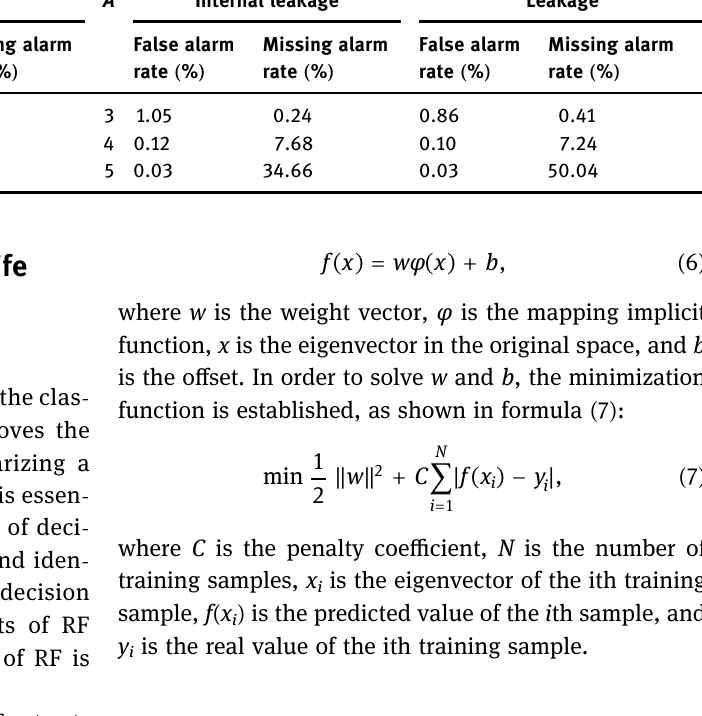
Table 2: FMU performance degradation detection